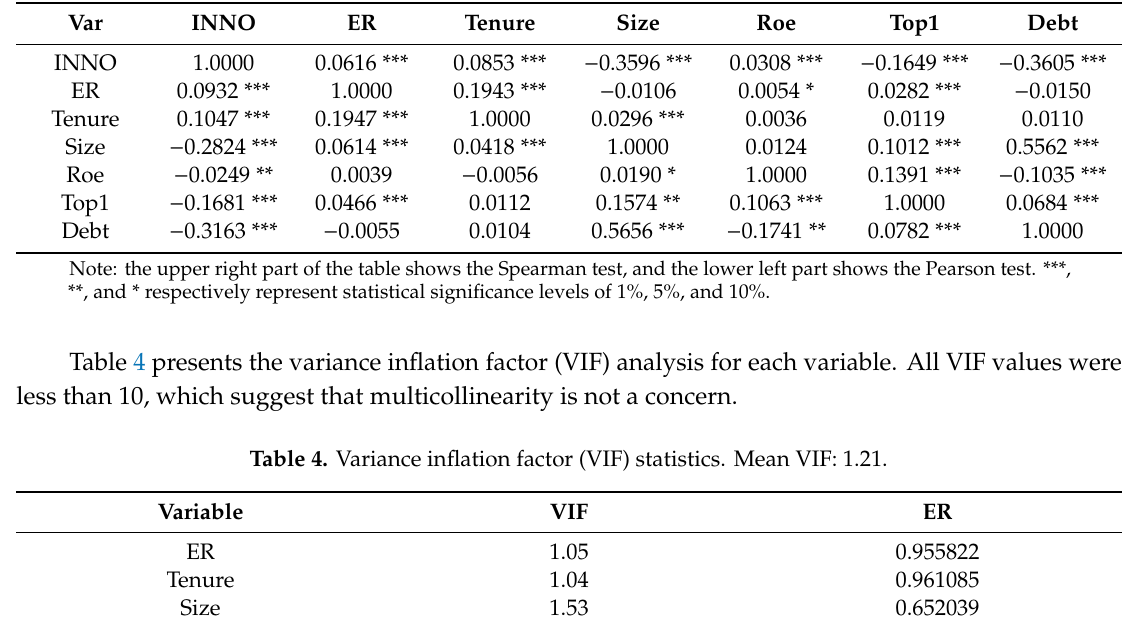
Table 3. Correlation coe ffi cients of main variables.